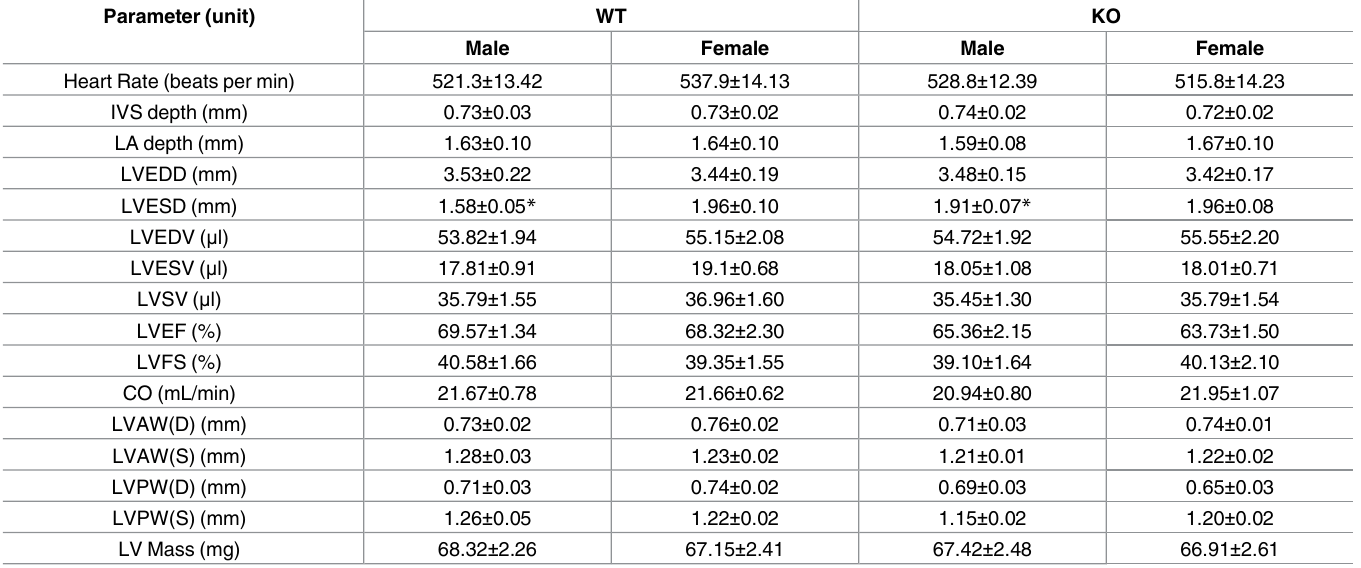
Table 4. Cardiac ultrasound parameter data.